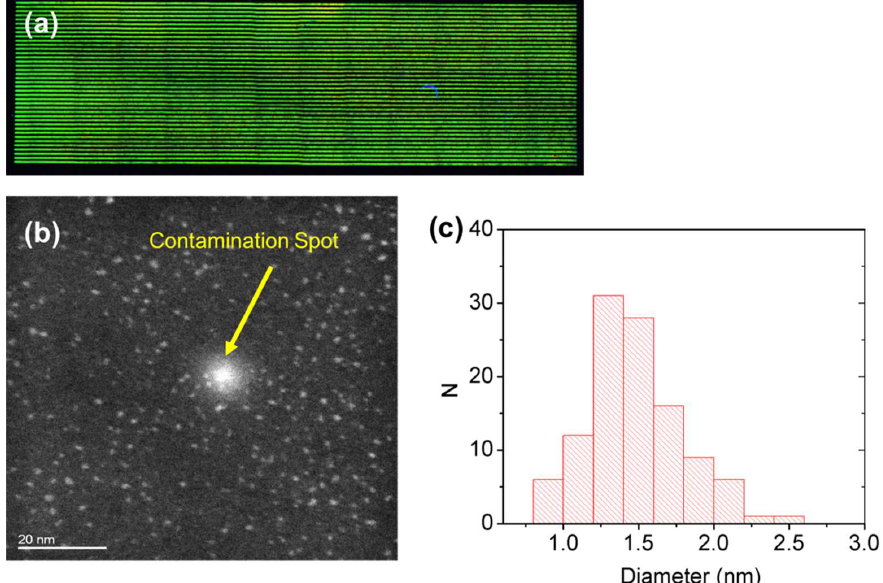
Figure 9. ( a ) Fluorescent microscope image of the large area samples obtained with the “green” laser parameters and the HAADF-STEM images ( b ) and the histogram of the particle size distribution ( c ). The image contrast is blurred by heavy contamination (white dot indicated by the yellow arrow), which is probably due to carbon formation under the electron beam.